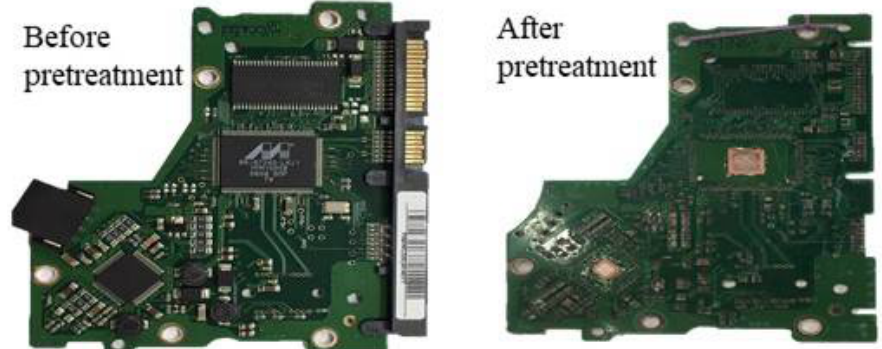
Figure 1. Waste PCBs sample before and after the pretreatment with HCl and Sn 4+